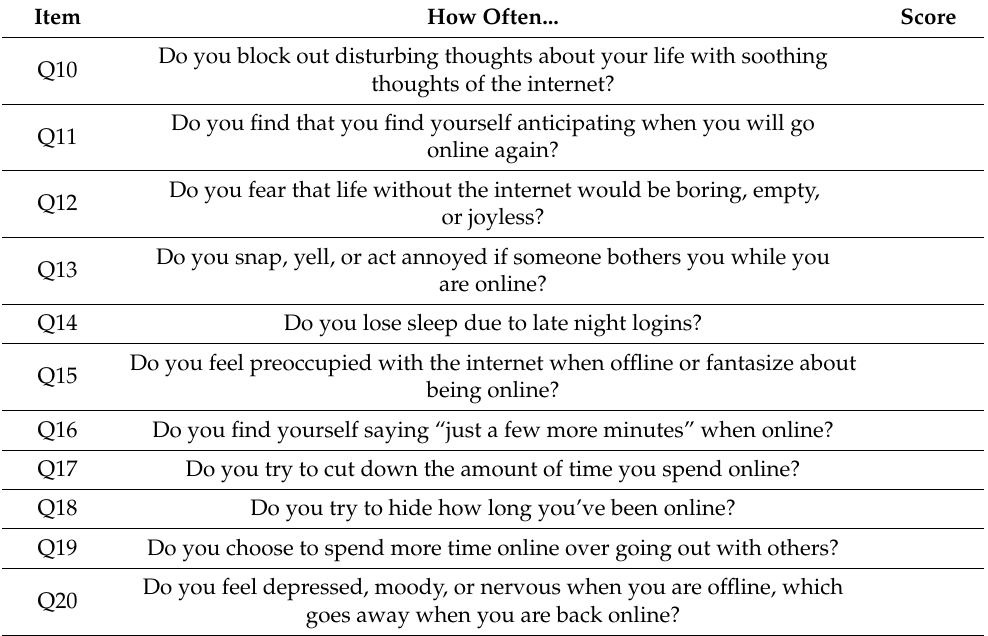
Table A1. Cont. Item How Often... Score Do you block out disturbing thoughts about your life with soothing thoughts of the internet?